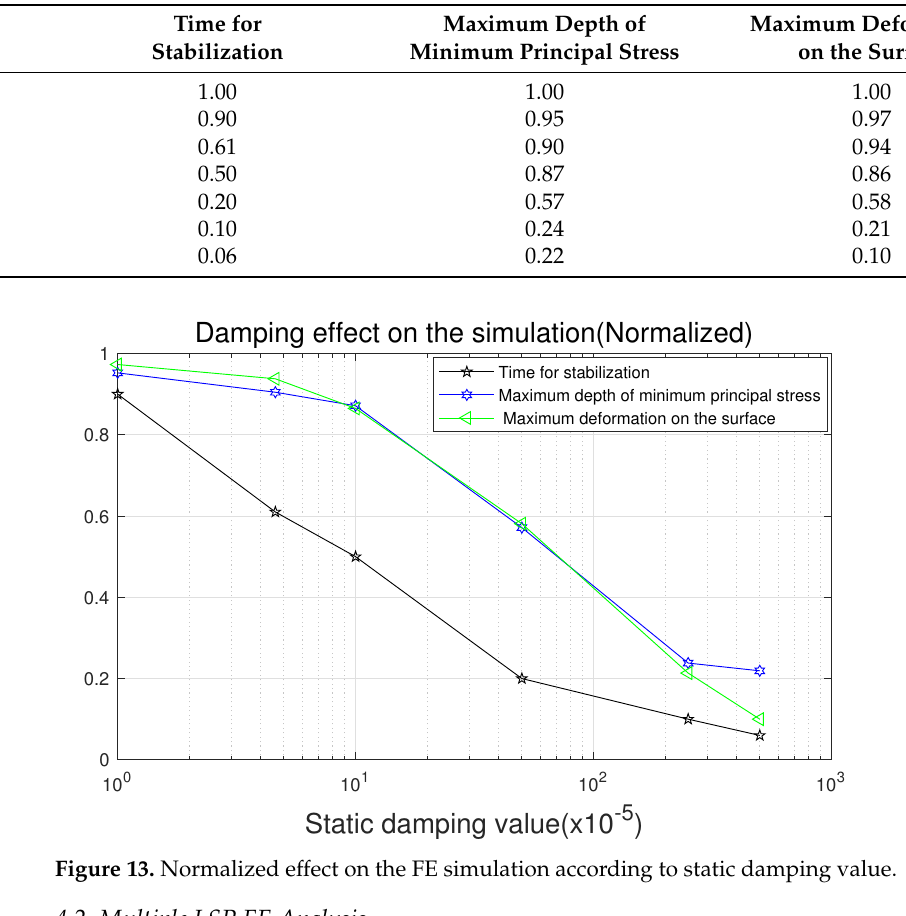
Table 3. Simulation result differences depending on the static damping.